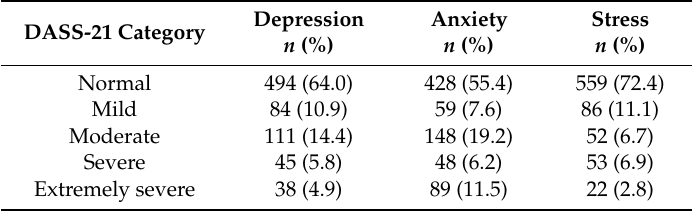
Table 2. Depression, anxiety, and stress symptoms prevalence according to categories.